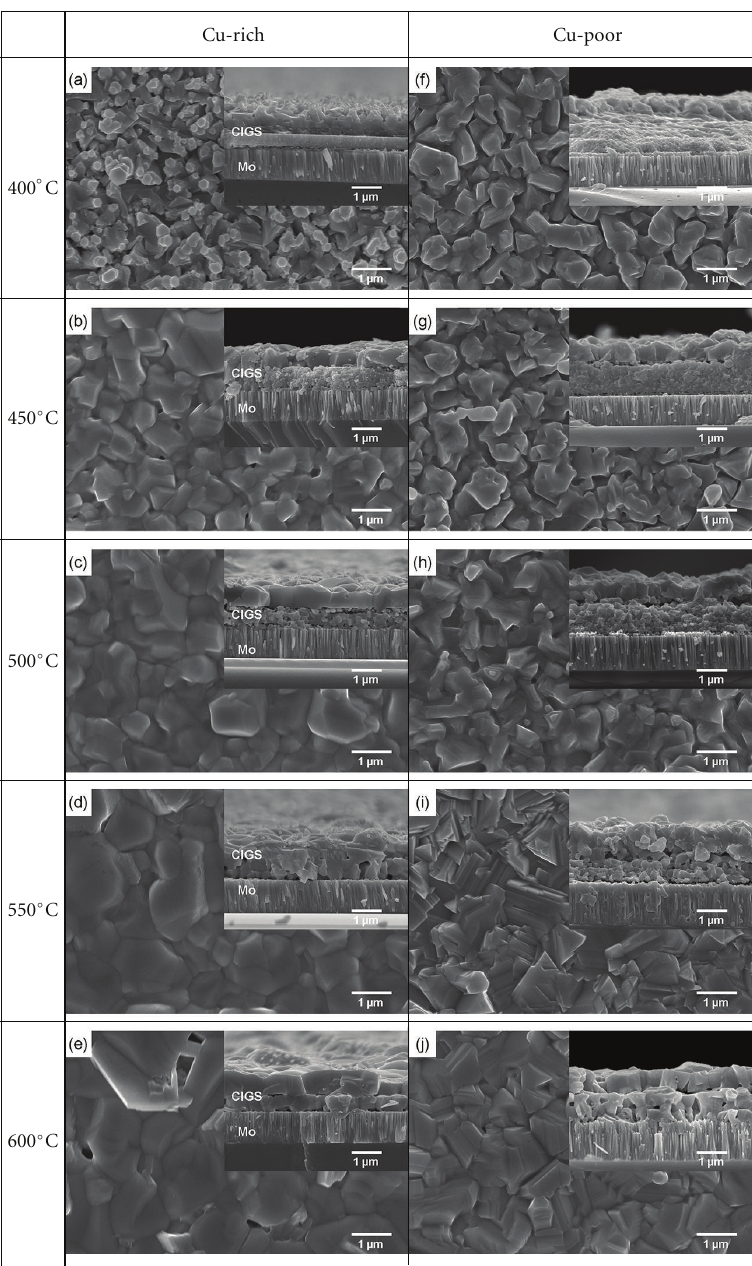
Figure 4: Comparison of surface and cross-section (insets) SEM images of CIGS films selenized from Cu-rich precursor films (left column) and Cu-poor precursor films (right column) at di ff erent selenization temperatures: (a), (f) 400 ◦ C; (b), (g) 450 ◦ C; (c); (h) 500 ◦ C, (d), (i) 550 ◦ C; (e), (j) 600 ◦